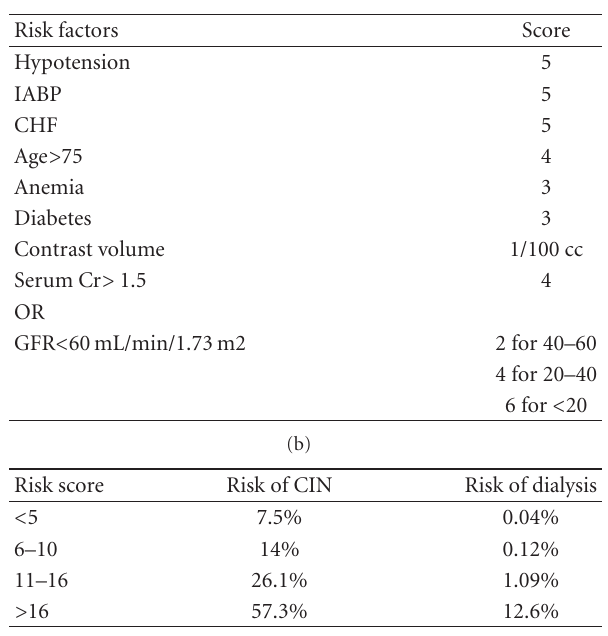
Table 3: Risk score for prediction of contrast-induced nephropathy by Mehran et al. [35]. IABP, intra-aortic balloon pump; CHF, congestive heart failure; eGFR, estimated glomerular filtration rate. Reprinted from